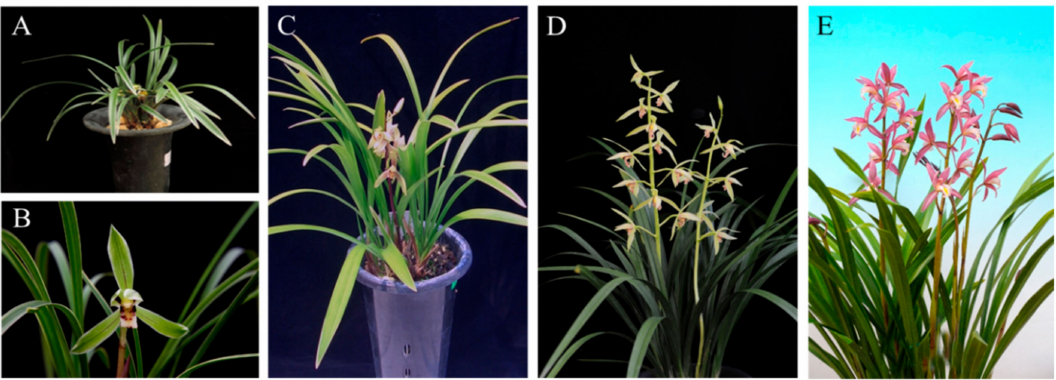
Figure 3. Cymbidium flowers described to the floral scent. ( A ) C. goeringii , ( B ) C. faberi , ( C ) C. ensiforium , ( D ) C . “Sael Bit,” ( E ) C . “Sunny